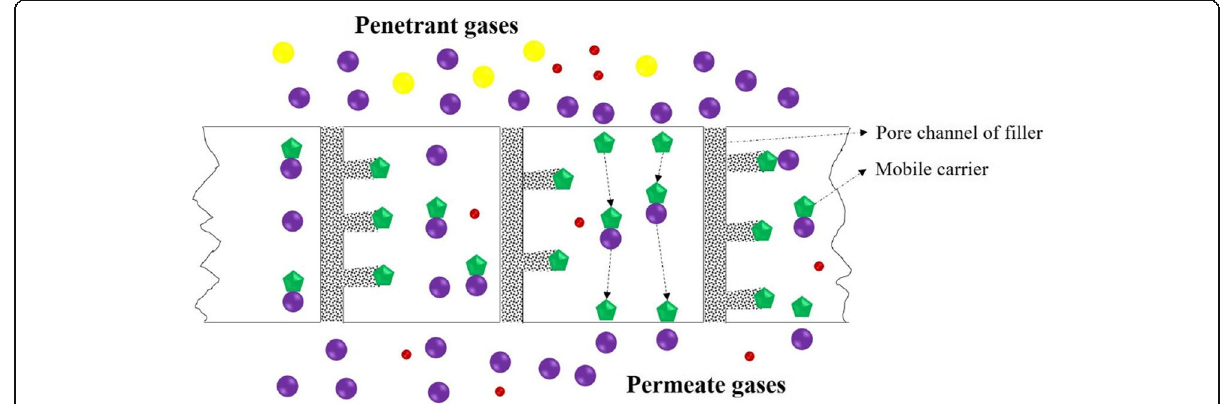
Fig. 5 Solution-diffusion mechanism by facilitated transport MMMs, adapted from Salim and Ho [57]